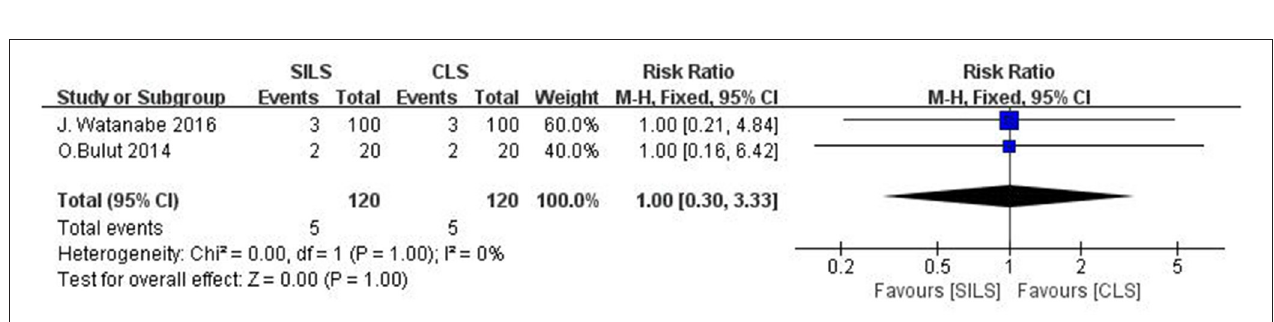
Publication Bias and Sensitivity